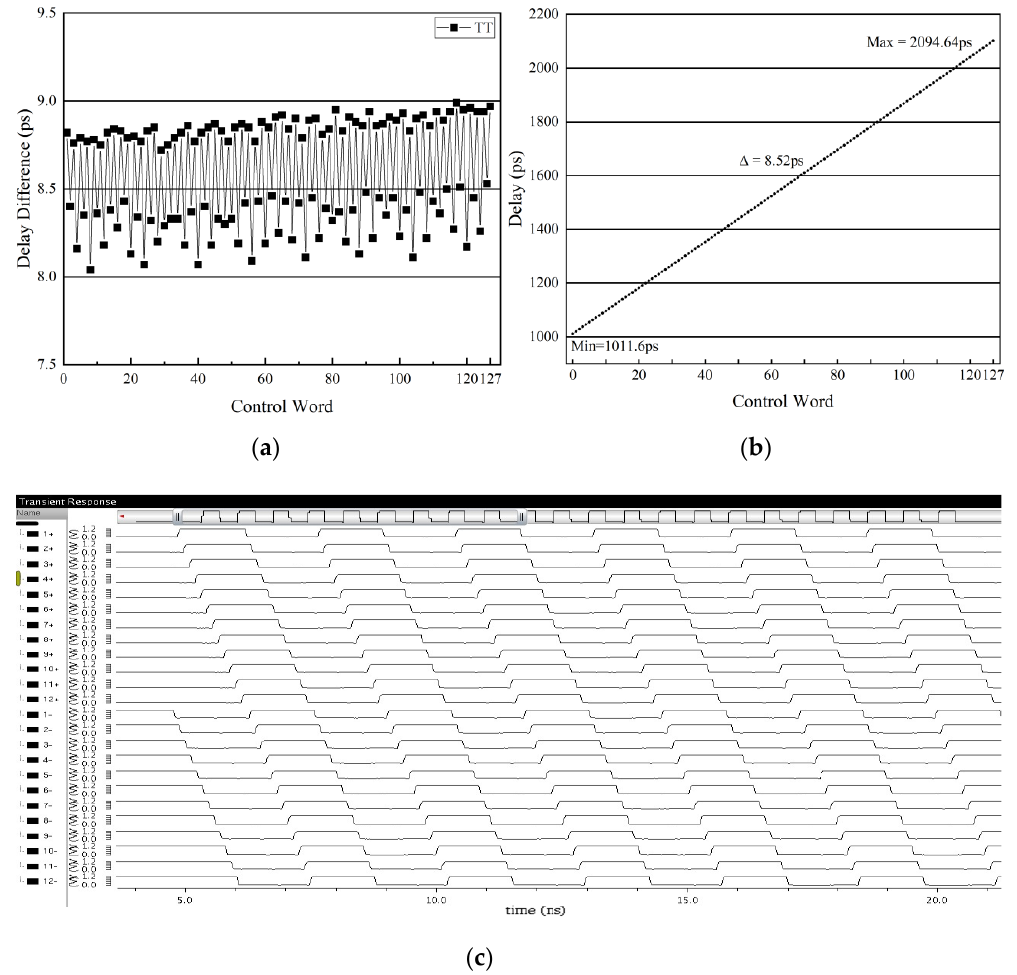
Figure 16. ( a ) Delay resolution at the process corner TT in 25 °C ( b ) Relationship between the delay time and the 7 bit control code; ( c ) The 24 phases provided by the replica delay line to the Vernier